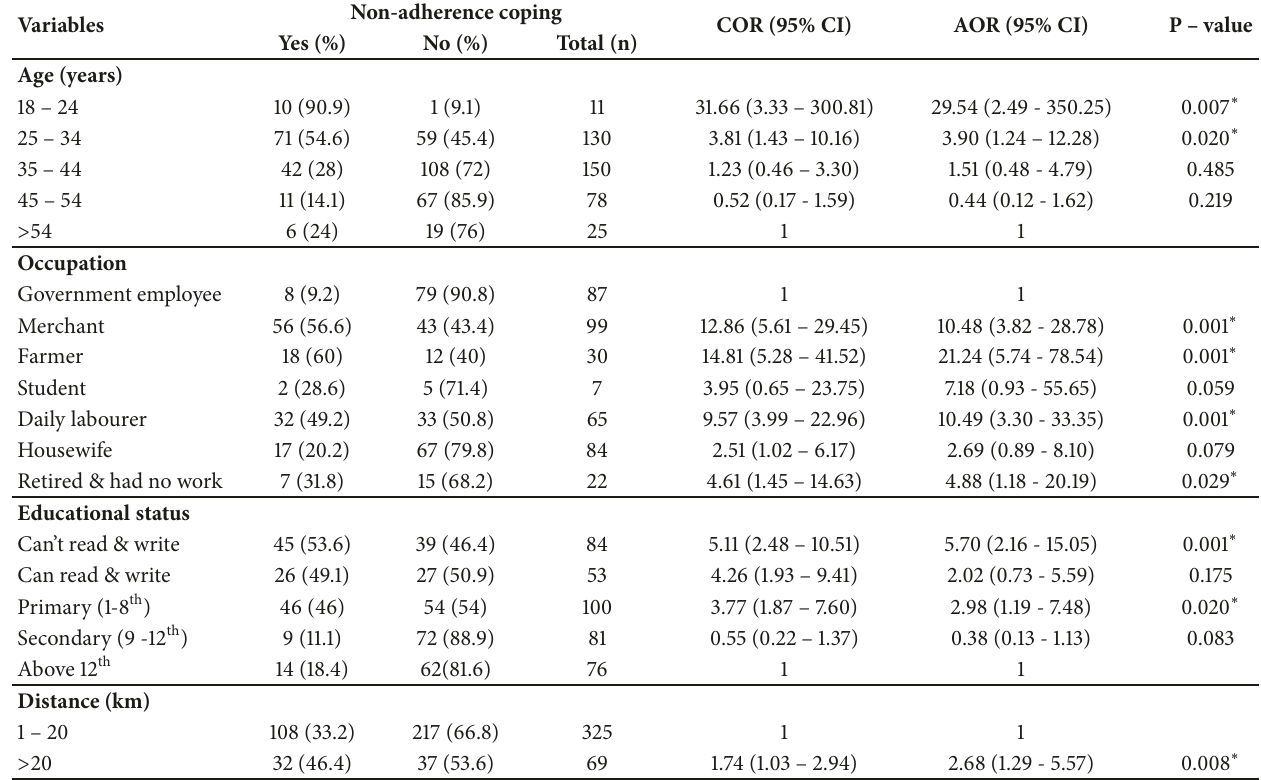
Table 7: Univariate and multivariate analysis of factors associated with nonadherence coping strategy at